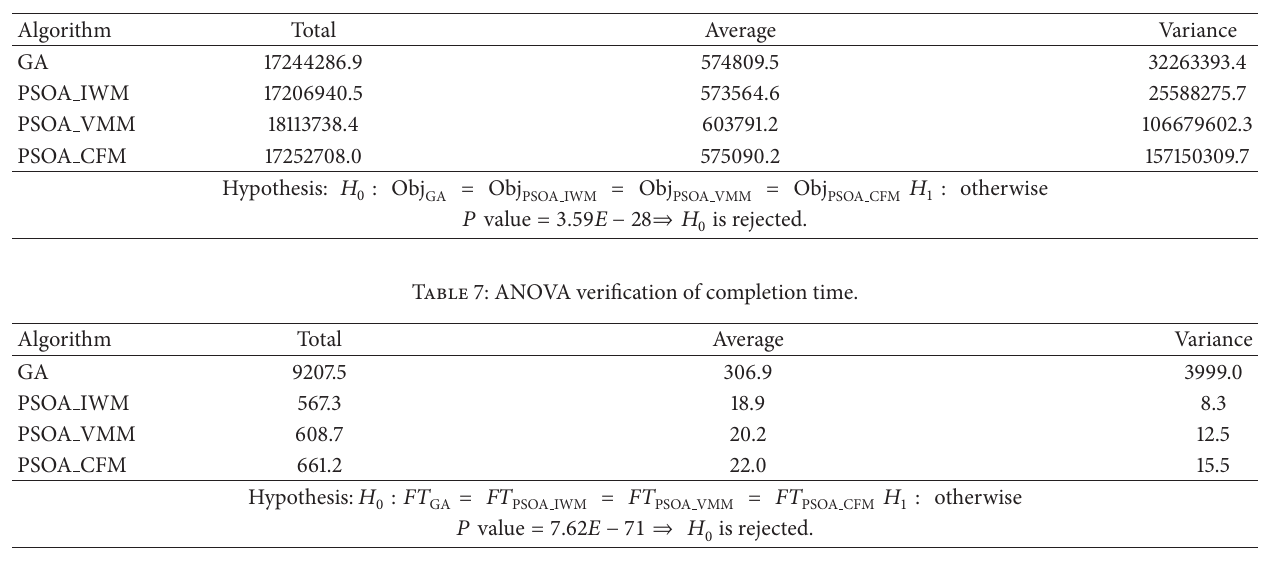
Table 6: ANOVA verification of objective function.